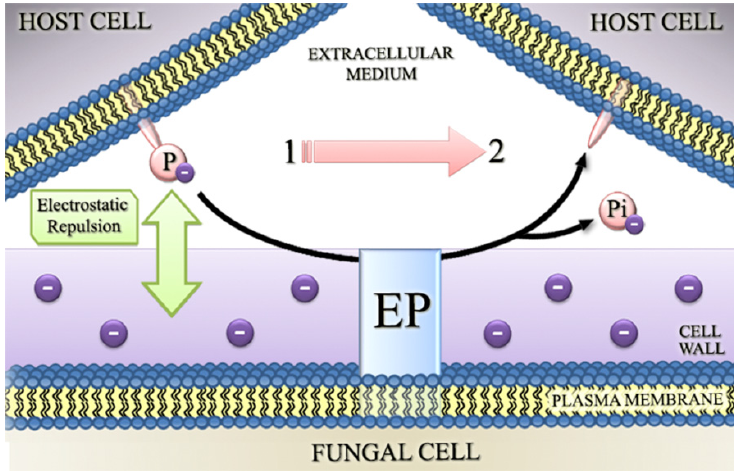
Figure 2. The removal of inorganic phosphate could expose additional sites for the interaction of infectious agents with the host surface. Phosphorylated proteins may contain binding sites for fungal adhesins. Dephosphorylation promoted by ectophosphatase activity could therefore expose these sites, thus contributing for fungal adhesion and